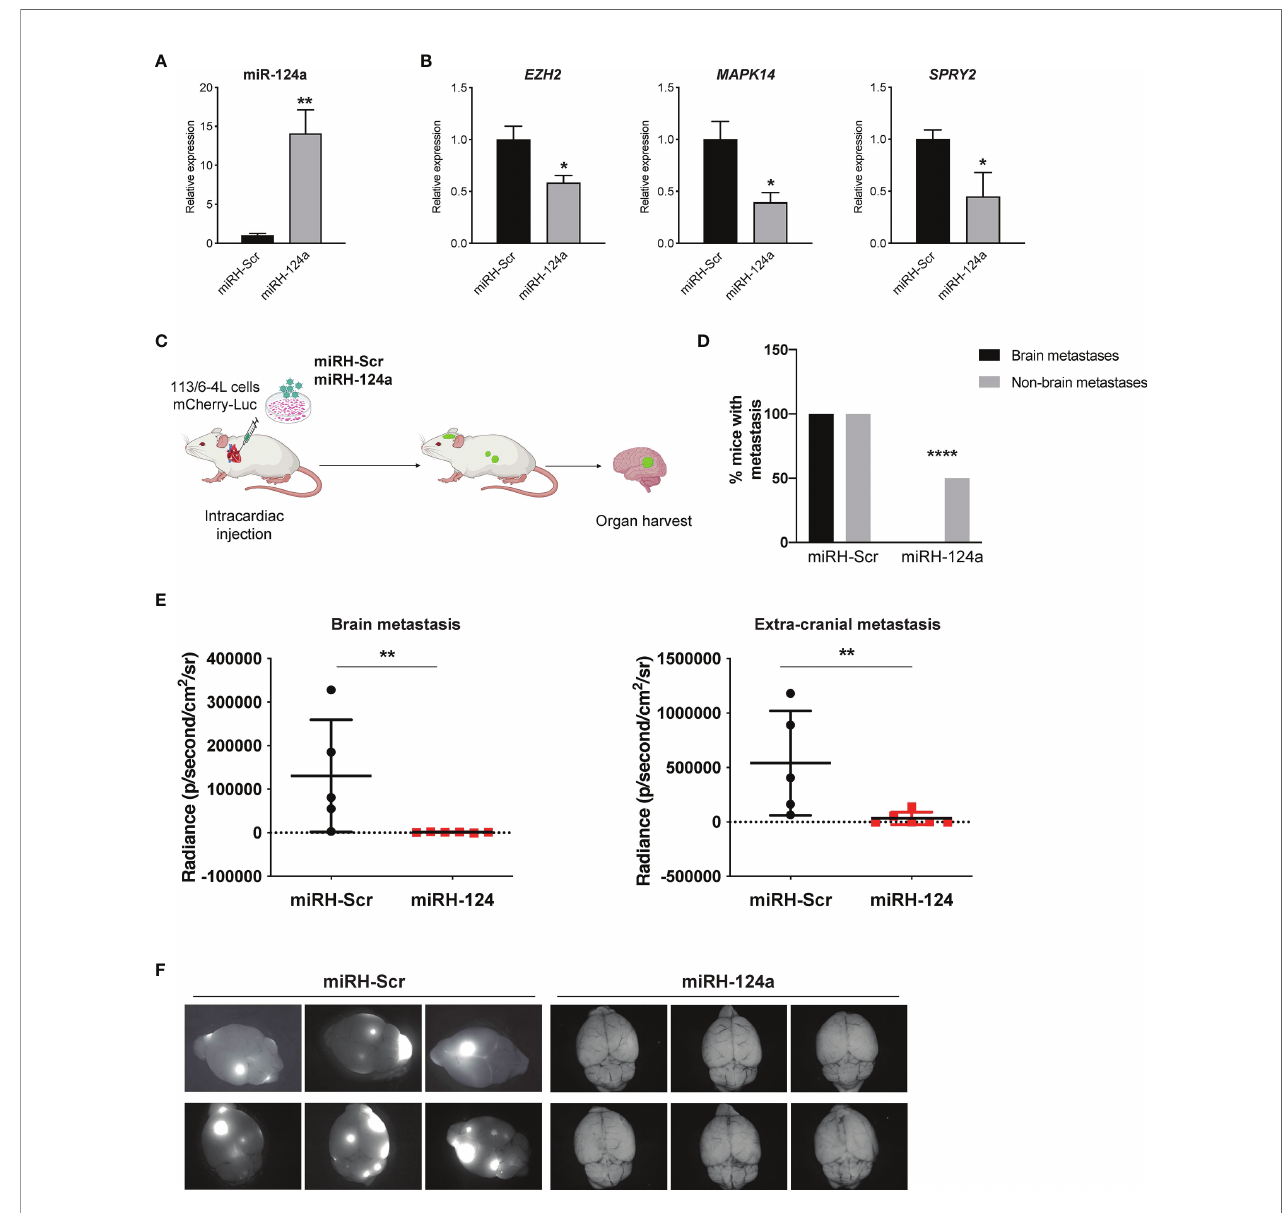
FIGURE 3 | miR-124a constitutive overexpression suppresses metastasis and particularly brain metastasis. The 113/6-4L-mCherry-Luciferase cells were transduced with miRH-Scr or miRH-124a tagged with a GFP reporter. (A) Ef fi cient miRNA-124a overexpression (unpaired t test; **p = 0.0083) and (B) consequent repression of its targets were measured by quantitative RT-PCR (unpaired t test; EZH2 *p = 0.05, MAPK14 *p = 0.02, and SPRY2 *p = 0.038). (C) Schematic representation of the in vivo metastasis model using cells generated in (A) in nude female mice (n = 6 per group). (D) Incidence of brain and extracranial metastases in both groups is shown. Extracranial metastases refer to lung and/or ovary metastases (two-sided chi-square test, ****p < 0.0001). (E) miR-124a overexpression signi fi cantly inhibits both brain (**p = 0.0043) and extracranial metastasis (**p = 0.0087) burden, as measured by in vivo bioluminescence imaging using IVIS at experiment termination (Mann – Whitney test). (F) Representative GFP fl uorescence pictures of brain metastasis in mice from both groups are shown